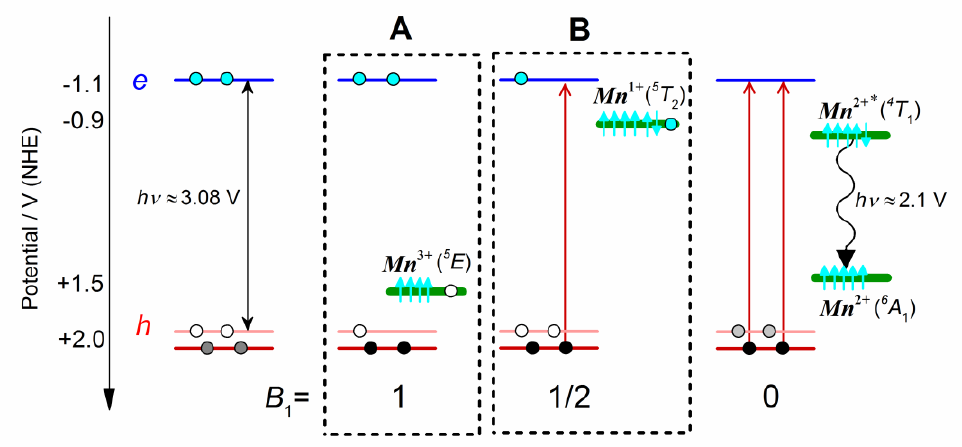
Scheme 1. Electronic configurations of the 2 alternative charge-transfer intermediates ( A ) and ( B ) that can be responsible for a 2-step energy transfer from the X1 exciton to Mn 2+ ions + and the overall